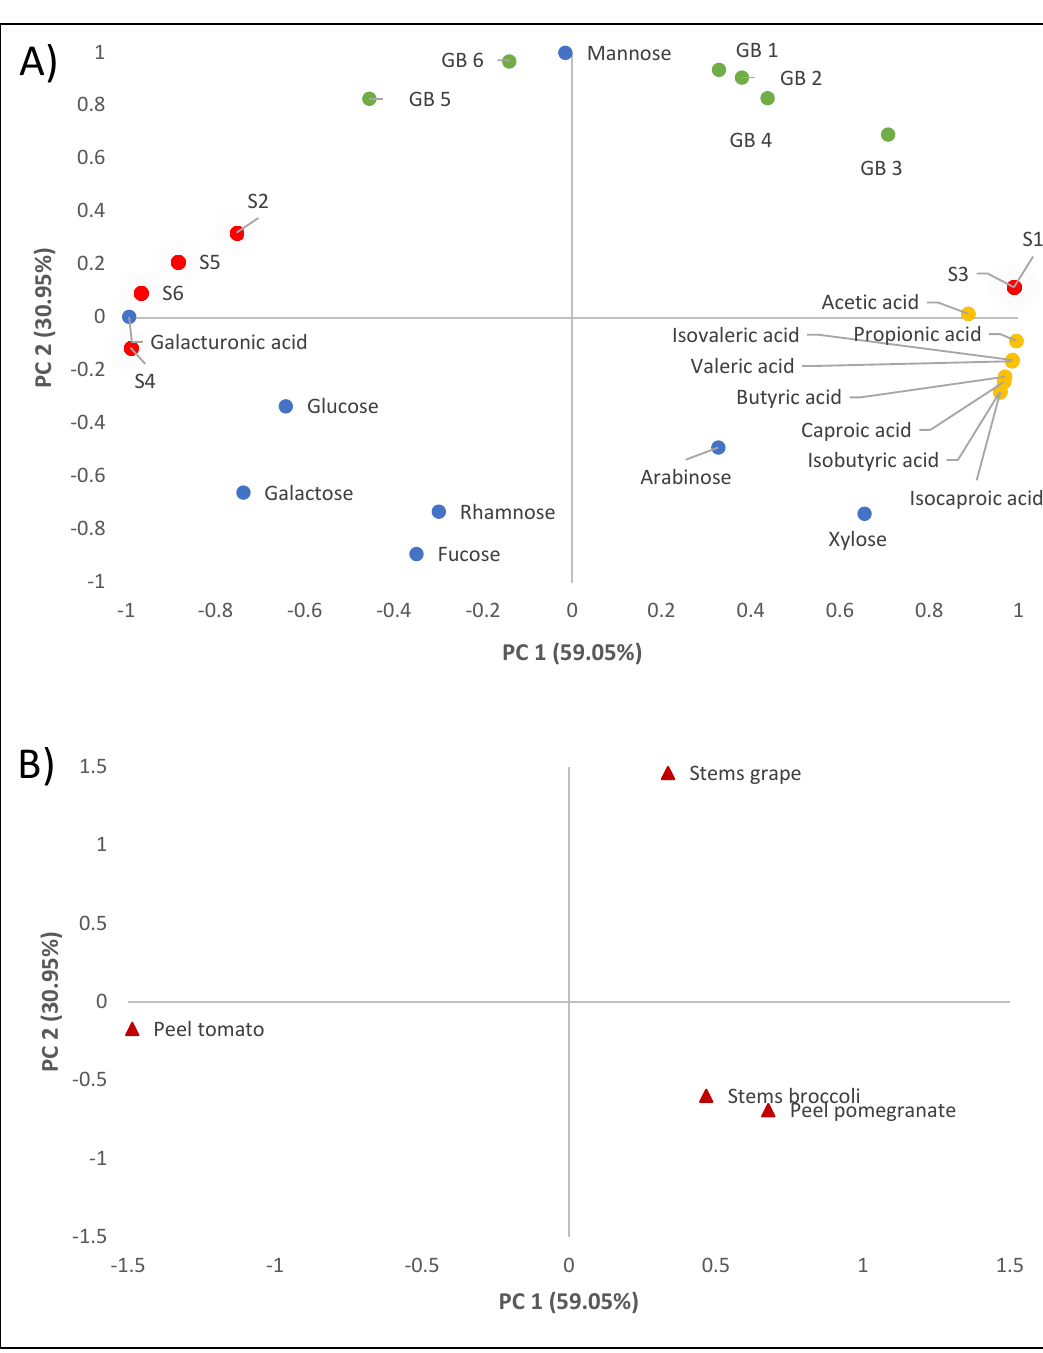
Figure 1. Principal component analysis of the analytical results of the dietary fibre extracts studied. Loading plot ( A ). GB1: growth of E. faecium SE 906; GB2: growth of E. faecium SE 920; GB3: growth of L. casei HL 245; GB4: growth of L. casei HL 233; GB5: growth of L. reuteri PL 503; GB6: growth of L. reuteri PL 519; S1: survival in the gastrointestinal tract of E. faecium SE 906; S2: survival in the gastrointestinal tract of E. faecium SE 920; S3: survival in the gastrointestinal tract of L. casei HL 245; S4: survival in the gastrointestinal tract of L. casei HL 233; S5: survival in the gastrointestinal tract of L. reuteri PL 503; S6: survival in the gastrointestinal tract of L. reuteri PL 519. Score plot ( B ). Grape stem, broccoli stem, pomegranate peel, and tomato peel samples.